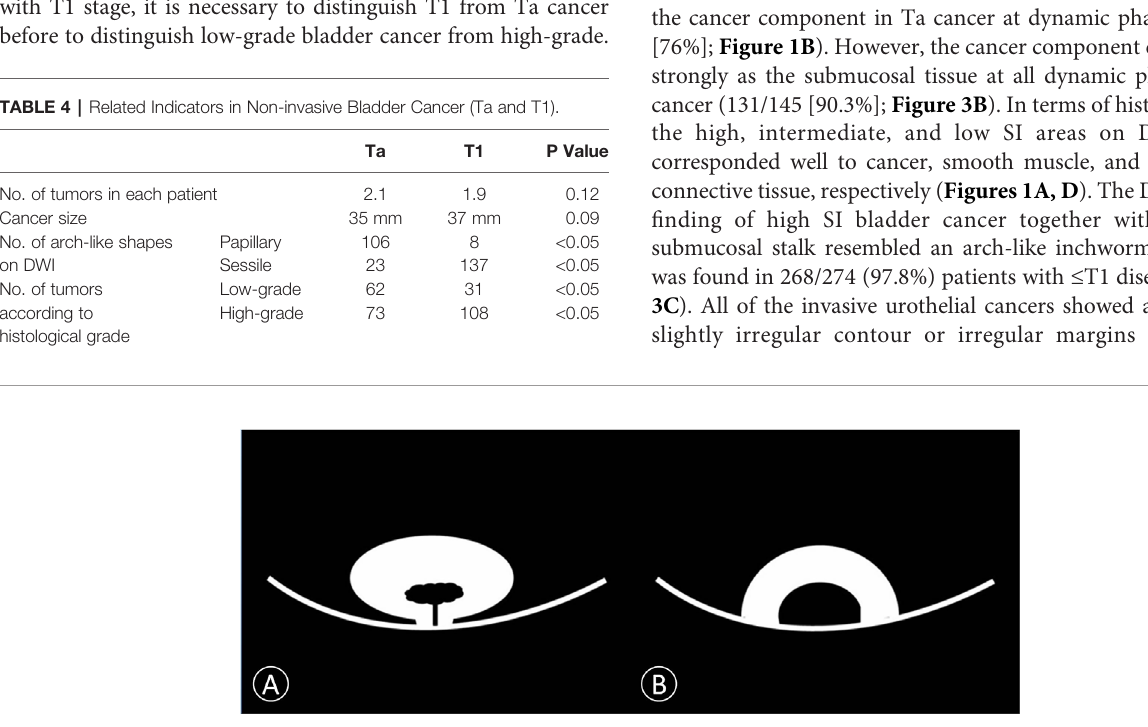
PPV, positive predictive value; NPV, negative predictive value.